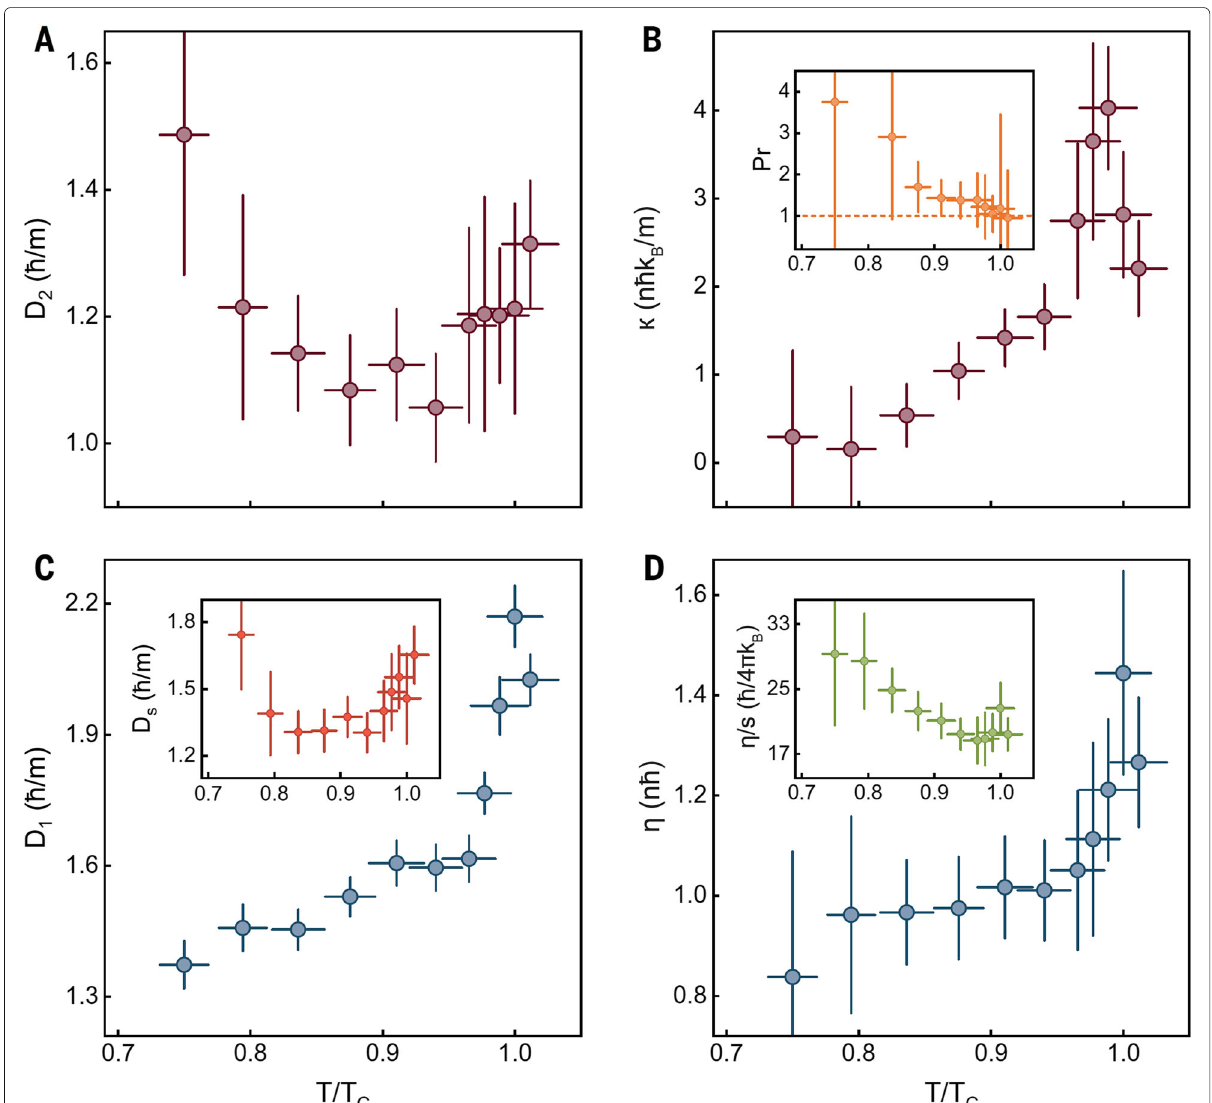
Fig. 16 a The second-sound diffusivity D 2 . b The thermal conductivity κ . The inset shows the Prandtl number, with the line marking Pr = 1. c The first-sound diffusivity D 1 , together with D s in the inset. d The shear viscosity η . The inset reports the viscosity-to-entropy ratio, in units of (cid:2) /( 4 π k B ) . From Ref.